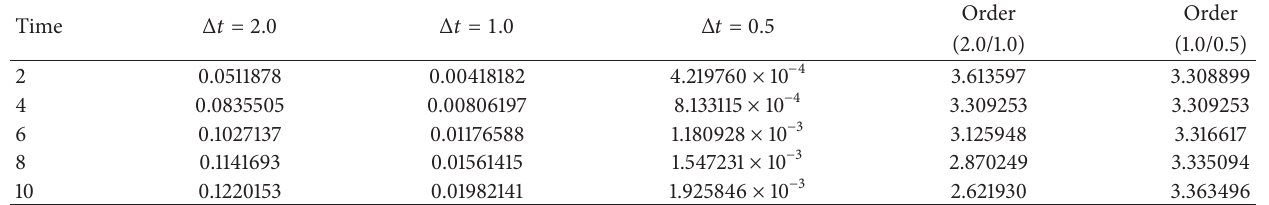
Table 8: The order of convergence in time for 𝐿 2 error norm with ℎ = 0.1 and 𝑐 = 0.3 .